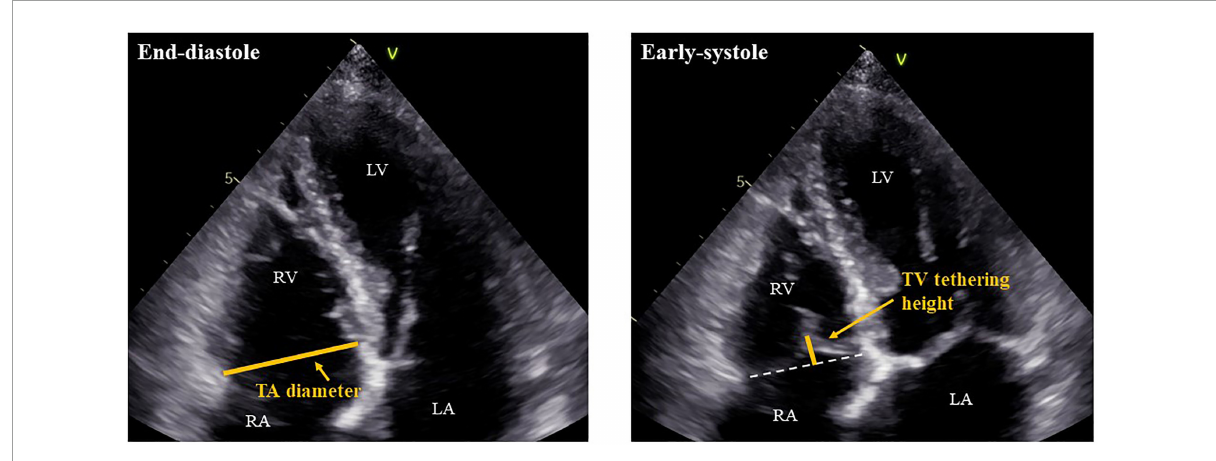
FIGURE2 Measurements of TA diameter and TV tethering height. RV, right ventricle; RA, right atrium; LV, left ventricle; LA, left atrium; TA, tricuspid annulus; and TV, tricuspid valve.